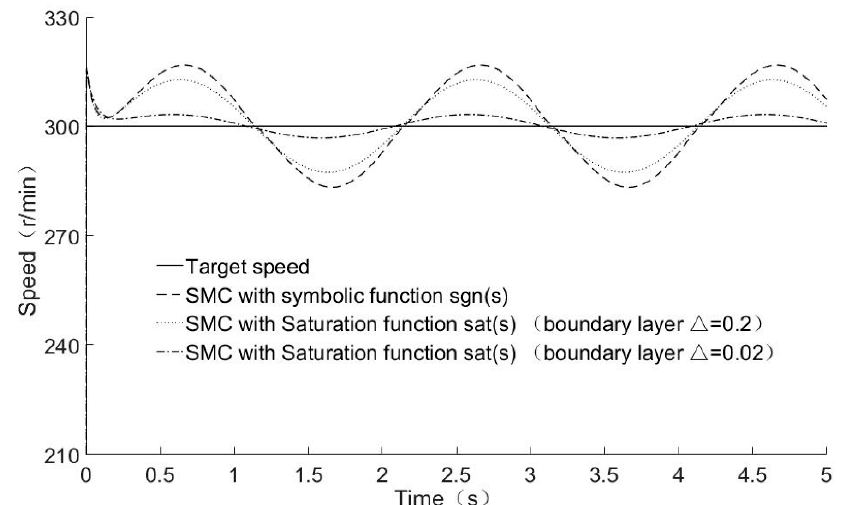
Figure 4. The simulation result of the speed fluctuation curve of the PMSM.